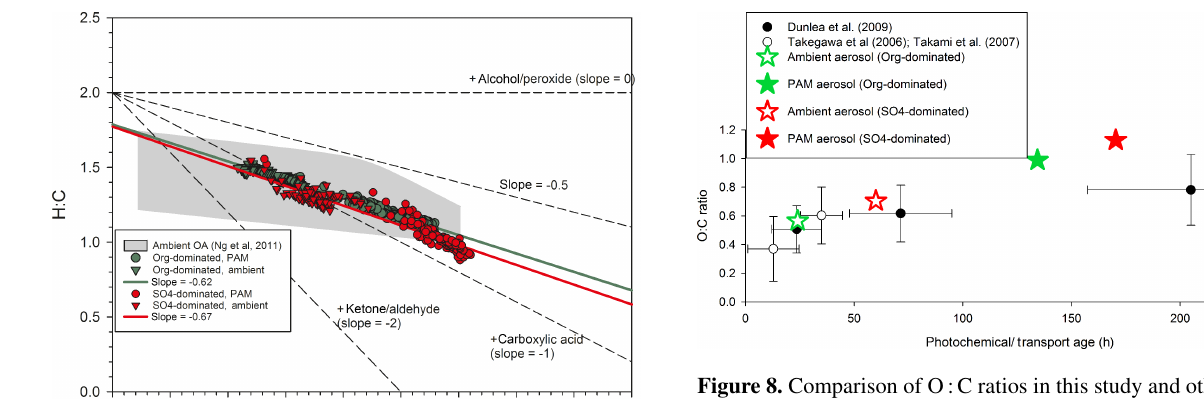
Figure 8. Comparison of O : C ratios in this study and other studies with respect to photochemical age. The photochemical ages in our measurements were obtained by the transport time calculated from a backward trajectory analysis and photochemical aging times in the PAM reactor. Other study data were obtained from Takegawa et al. (2006), Takami et al. (2007), and Dunlea et al.